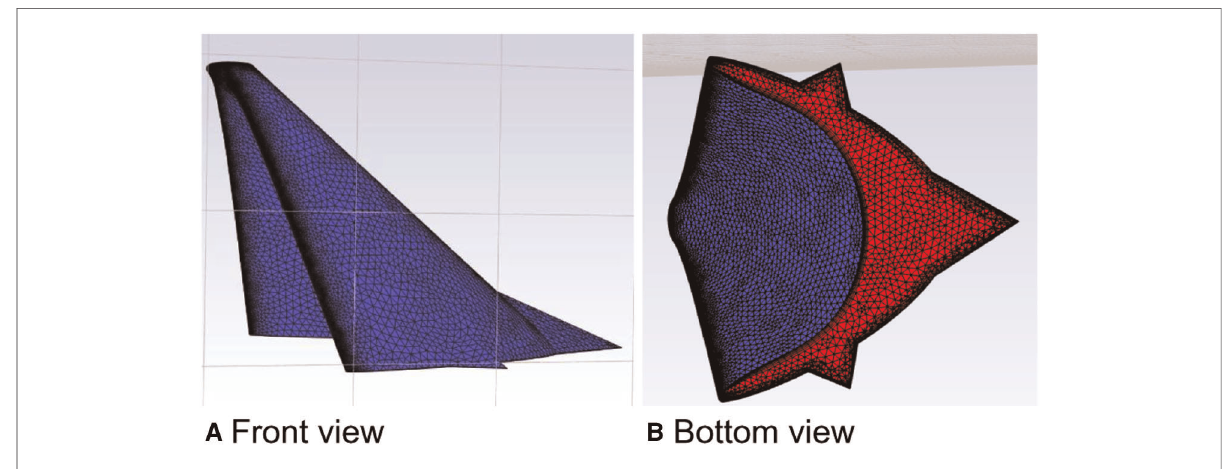
FIGURE 12 Straight model of the curved plus extended groove